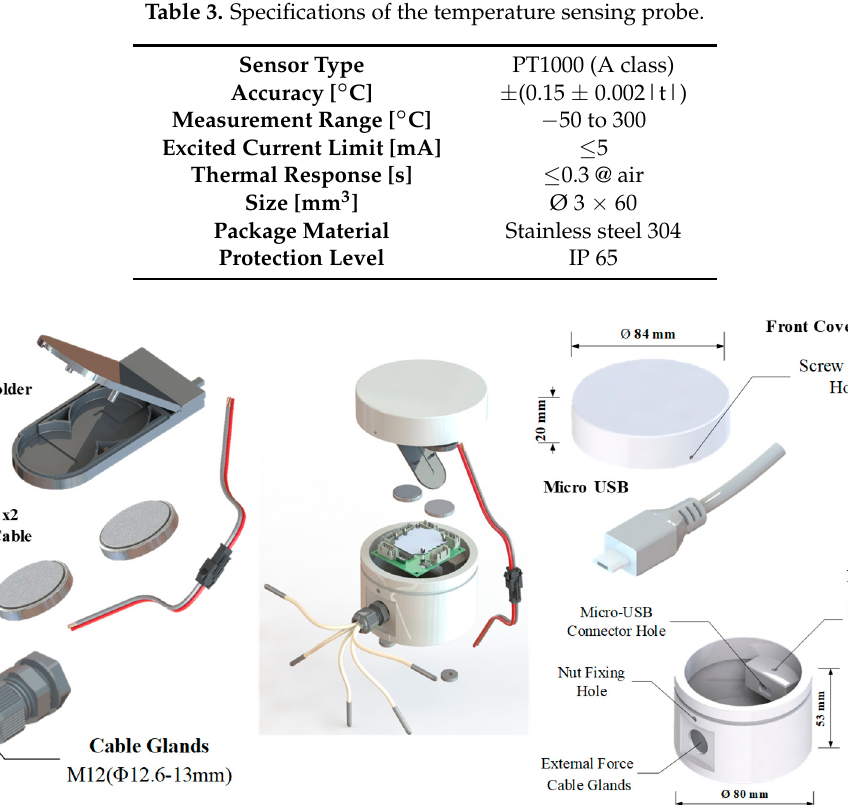
Figure 8. Introduction of all components used in the TSWTM.